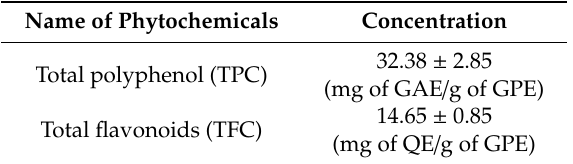
Table 1. Total polyphenols and total flavonoids contents in grape pomace solvent